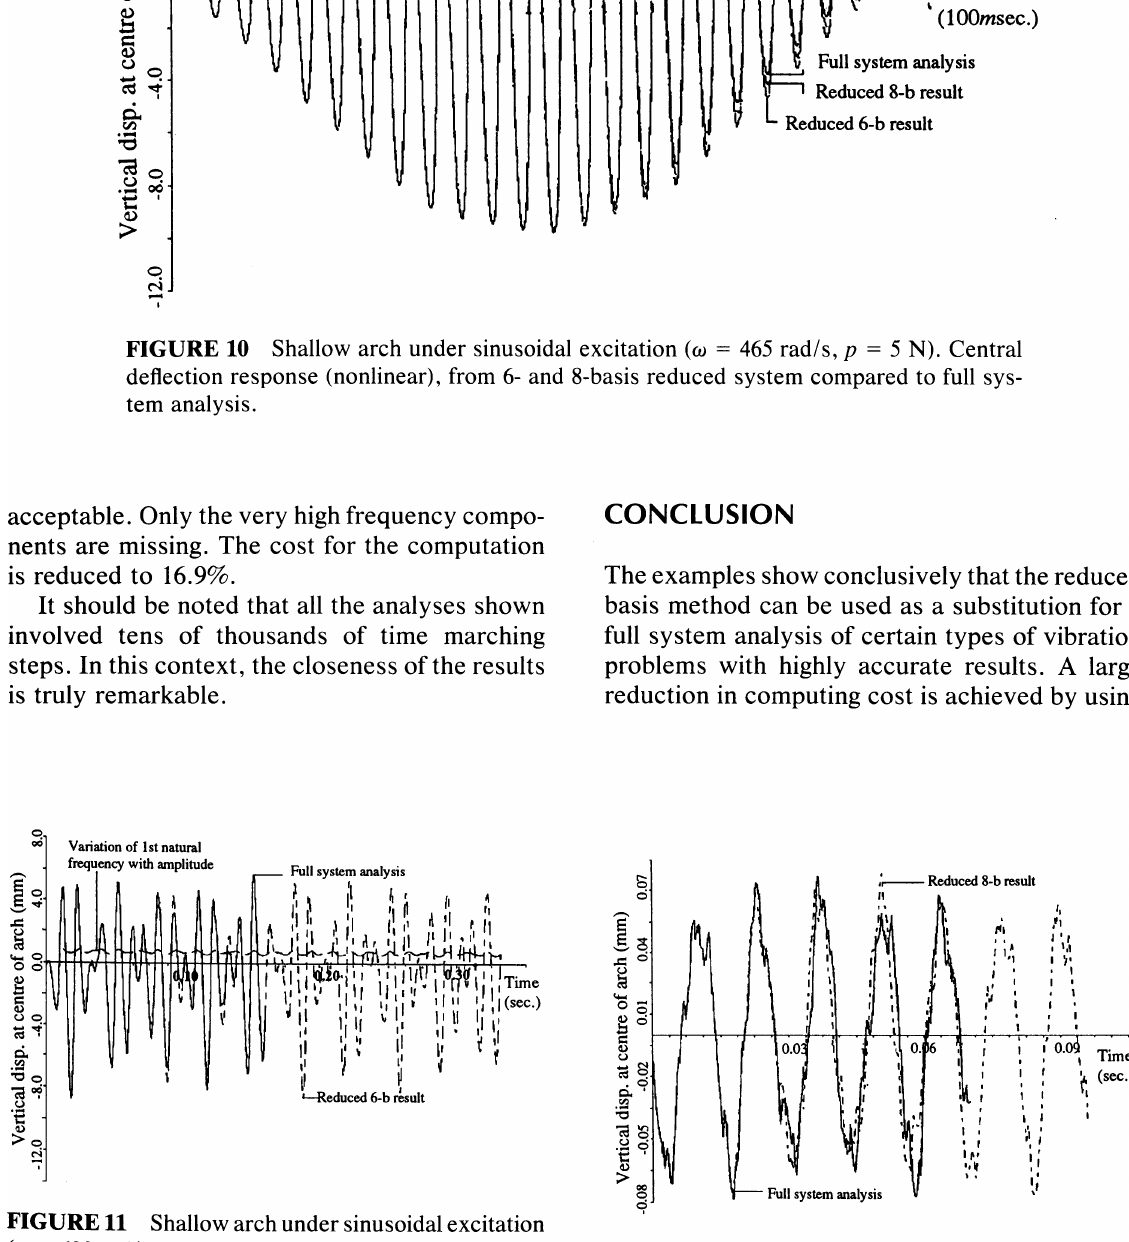
FIGURE 12 Shallow arch under impUlse load. Cen tral deflection response from 8-basis reduced system analysis compared to full